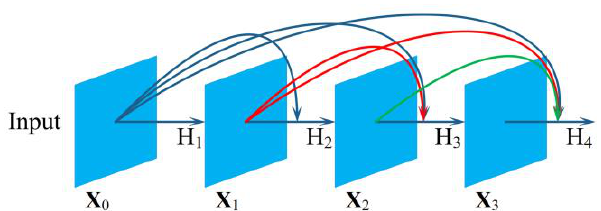
Figure 7. Example of a densely-connected architecture with four layers ( l = 4).